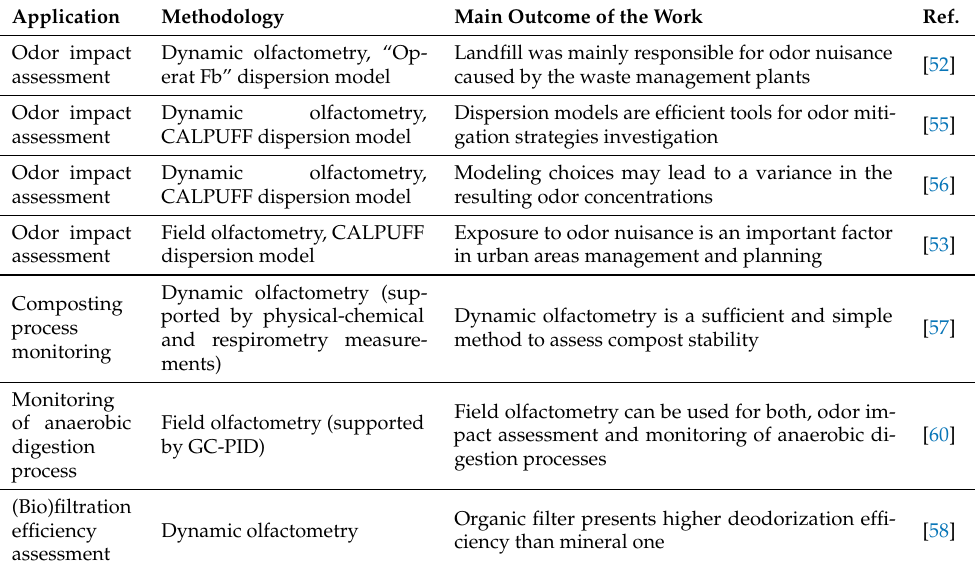
Table 3. Examples of recent applications of sensory measurement in the waste treatment